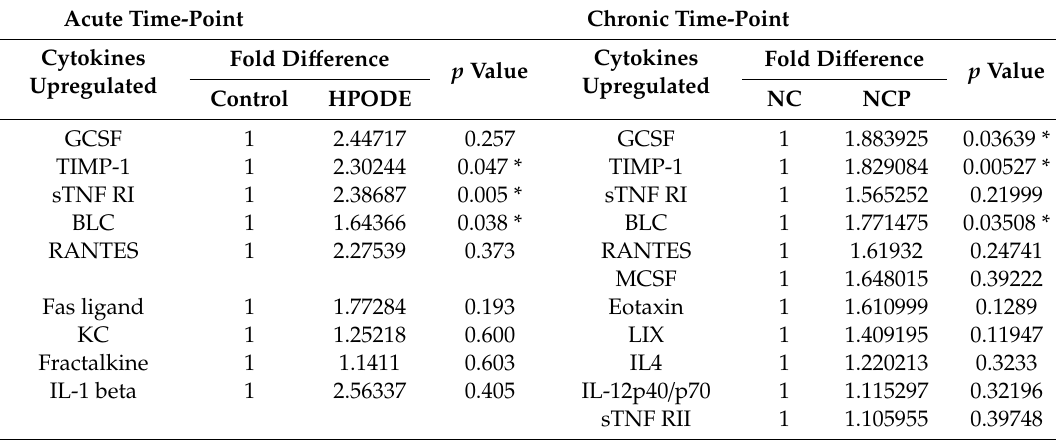
(Table 1) in 13-HPODE treated mice, as compared to the controls. The cytokine milieu confirms active inflammation caused by feeding with POLs and validates in vitro findings. Table 1. Cytokine array: Comparison of changes in inflammatory cytokines in mouse plasma between control and 13-HPODE-fed mice across both acute and chronic time points. Three samples from each group were analyzed by Ray-Bio ®® cytokine array analysis. Protein levels are expressed as fold-change between control and peroxide-fed groups. Significance was considered as * p <